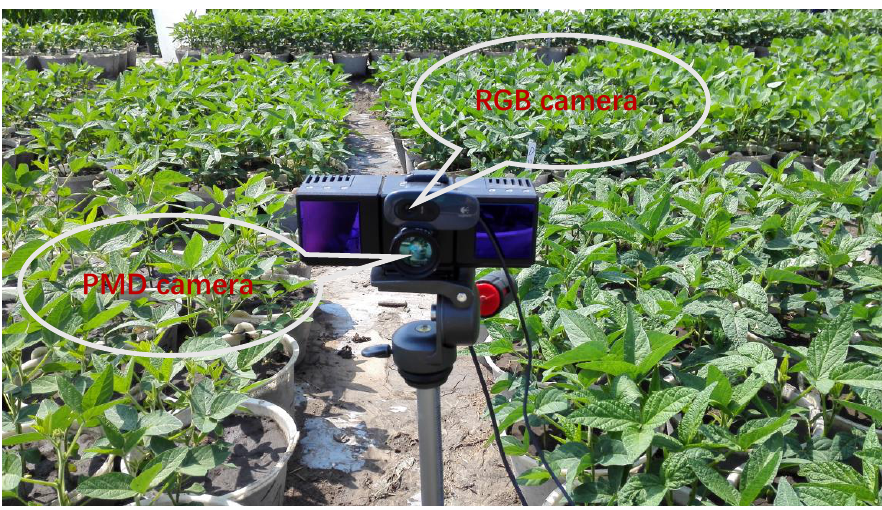
Figure 2. Multisource imaging system used in the soybean field.